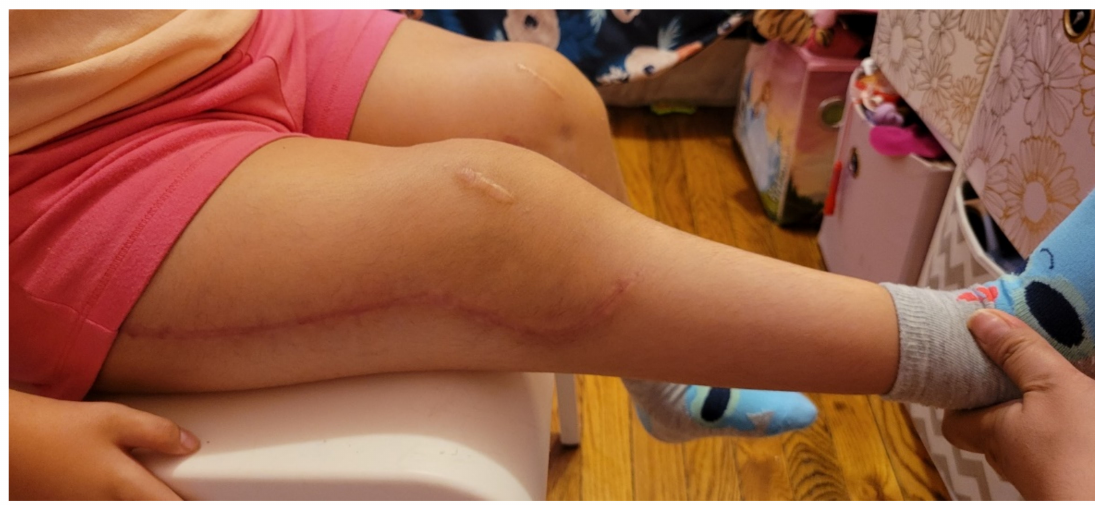
Figure 11. Clinical result of the patient from Figure 1.